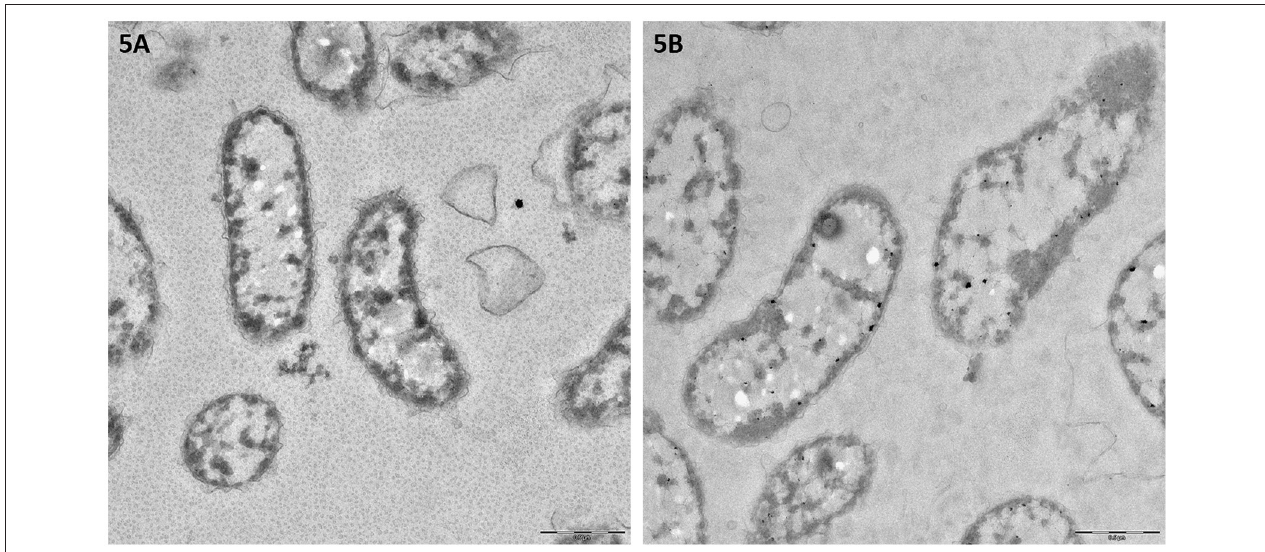
FIGURE 5 | TEM images of Vibrio anguillarum after toxicity testing exposure in 2% NaCl saline solution: control (A) and CuO NP dispersion (40 mg/l, B